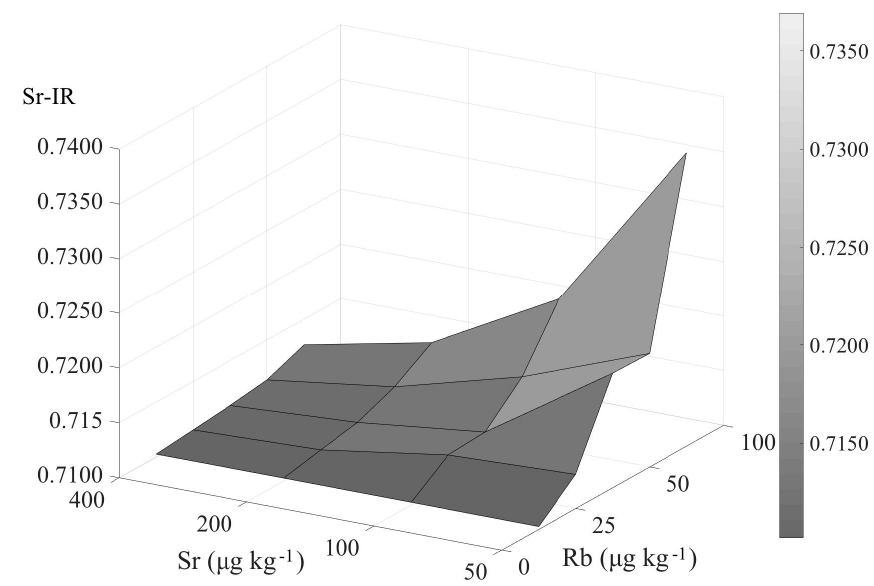
Figure 1. Values of 87 Sr/ 86 Sr determined on solutions varying both the Rb and Sr concentrations.